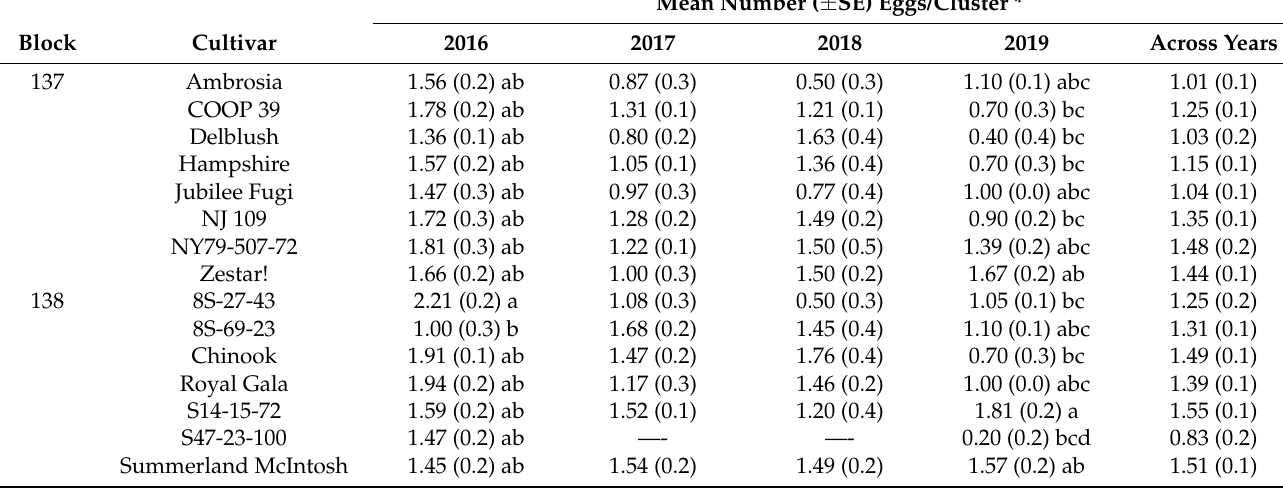
Table 3. Mean number ( ± SE) of Hoplocampa testudinea eggs/cluster from 15 cultivars located in 2 blocks at Kentville Research and Development Centre from 2016–2019. Letters within year denote significant differences between cultivars, p <